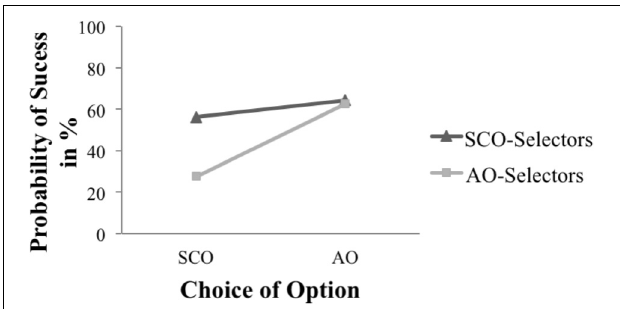
FIGURE 2 | Subjective probability of success for the two options.